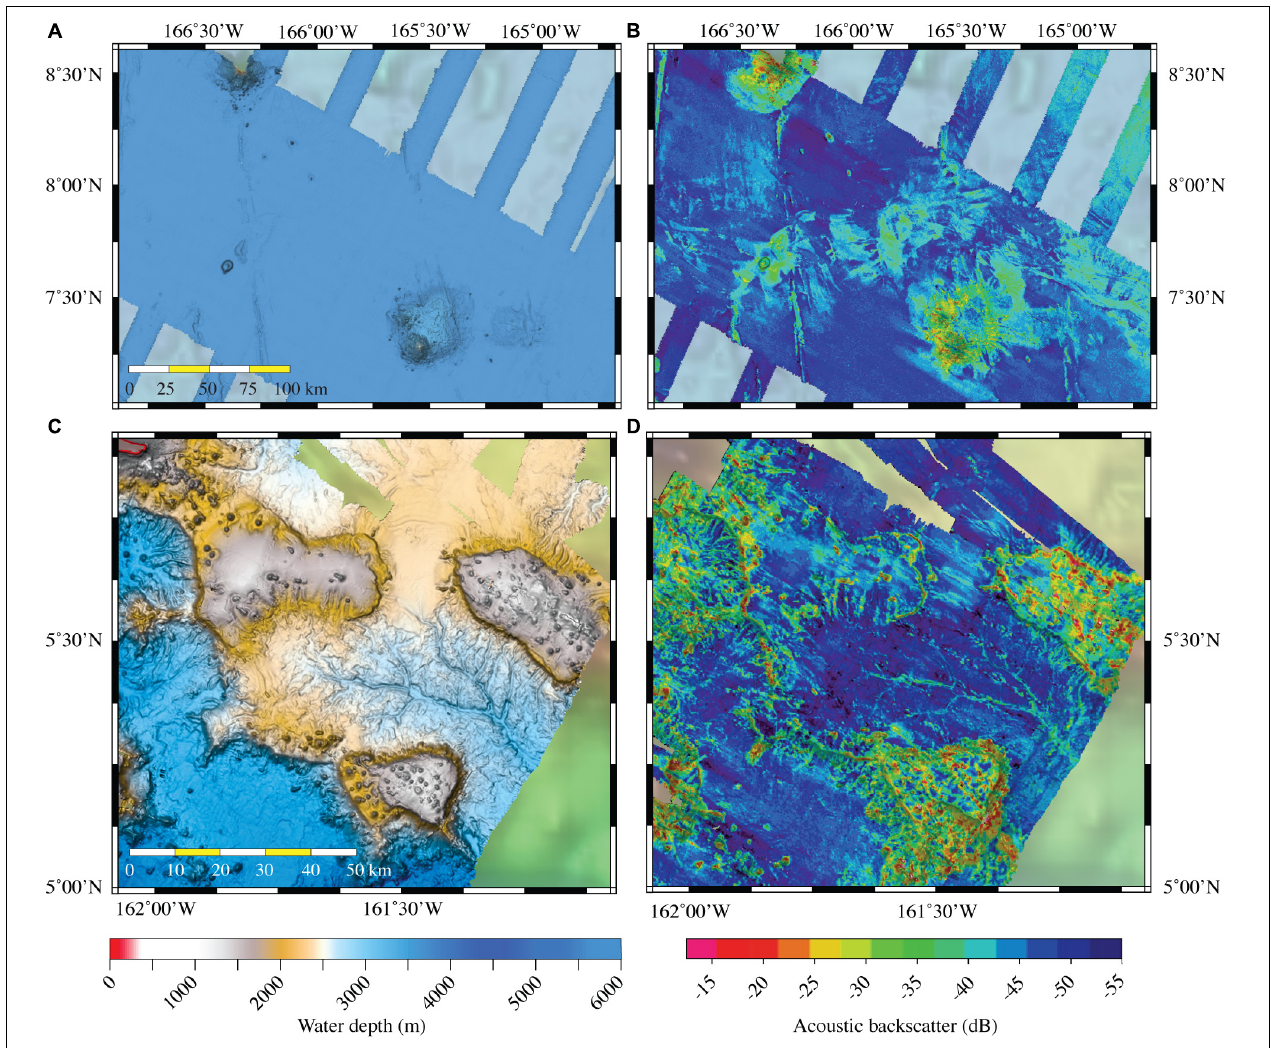
FIGURE 15 | (A) Map view of the bathymetry of a typical abyssal seamount immediately west of the NLIR and (B) same area showing acoustic backscatter of the seamount and adjacent abyssal seafloor. (C) Map view of the bathymetry of typical guyots on the NLIR and (D) same area showing acoustic backscatter of the guyots and adjacent seafloor. Locations of abyssal seamounts immediately west of Kingman Reef and Palmyra Atoll; location of guyots is area of CS-D southwest of Palmyra